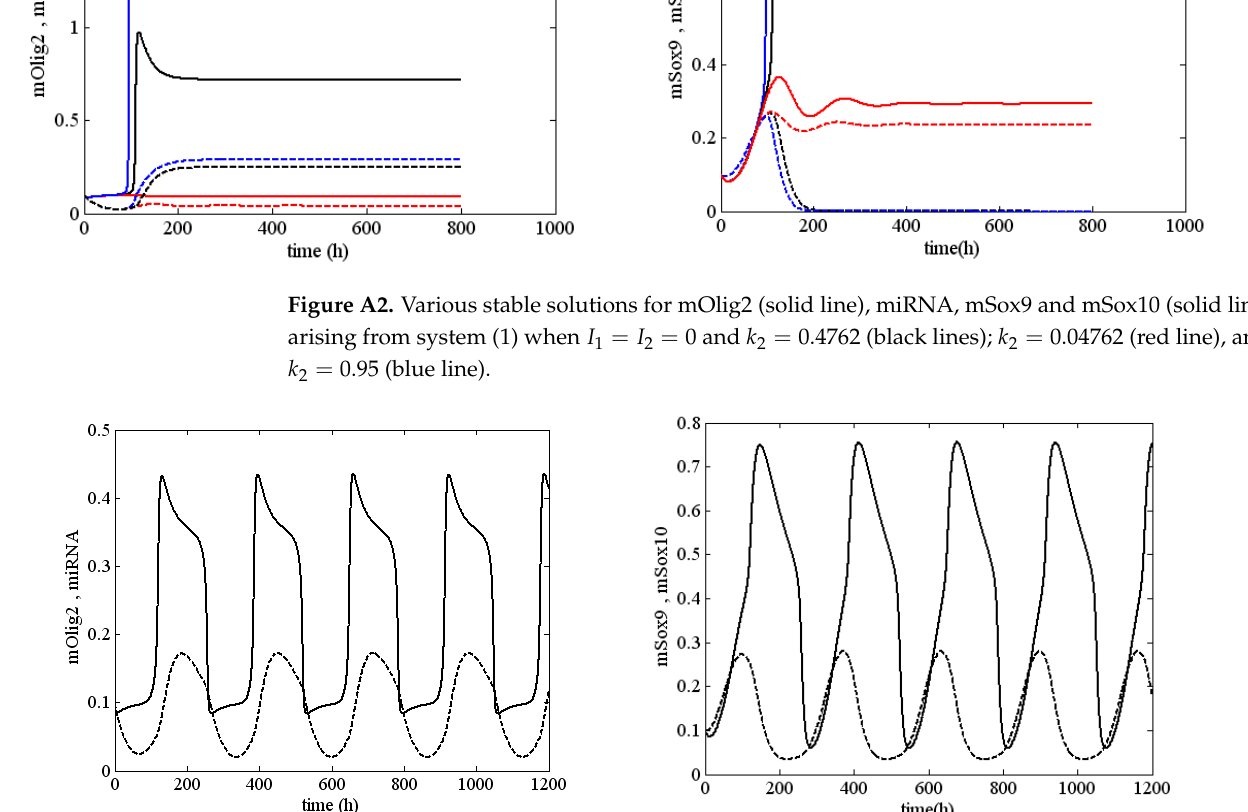
= k . The solution for = = I I and 2 . 0 2 2 1